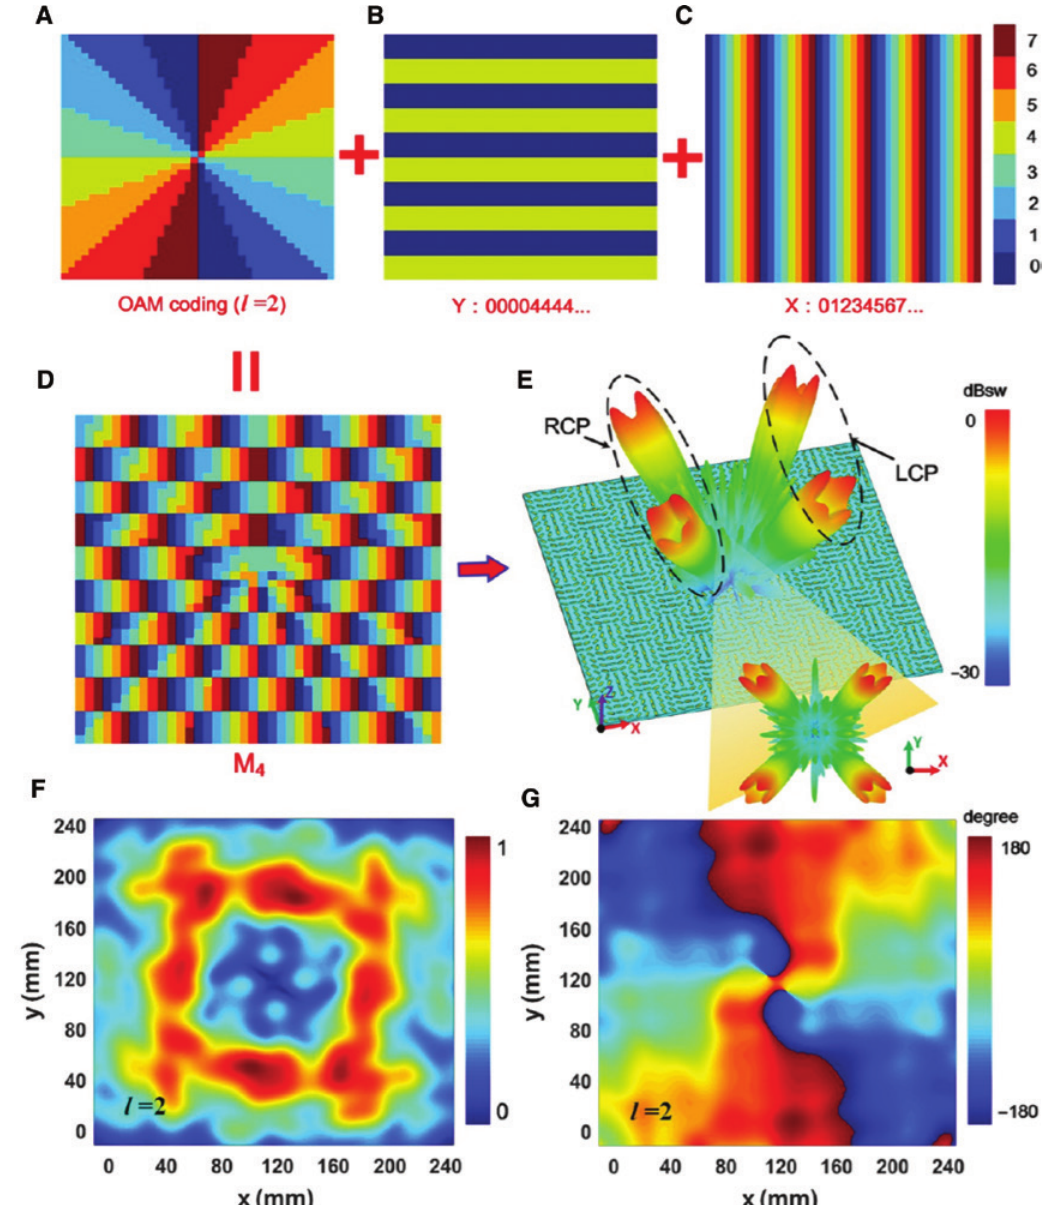
Figure 8: Coding patterns of the digital metasurface to control the vortex OAM beams with ℓ = 2 and simulated radiation patterns. (A) The coding pattern with OAM mode ℓ = 2. (B) The coding pattern with periodic coding sequence “0 0 0 0 4 4 4 4 … ” varying along the y direction, (C) the coding pattern with gradient coding sequence “0 1 2 3 4 5 6 7 … ” varying along the x direction. (D) The mixed coding pattern formed by the modulus of coding patterns in Figure 8(A)–(C). (E) The scattering pattern with four symmetrical vortex beams (OAM mode ℓ = 2). (F)–(G) Simulated near-field distributions of the coding pattern in Figure 8(A). (F) The normalized intensity distribution of the E component. (G) Is the phase distribution of the E component. Adapted from y